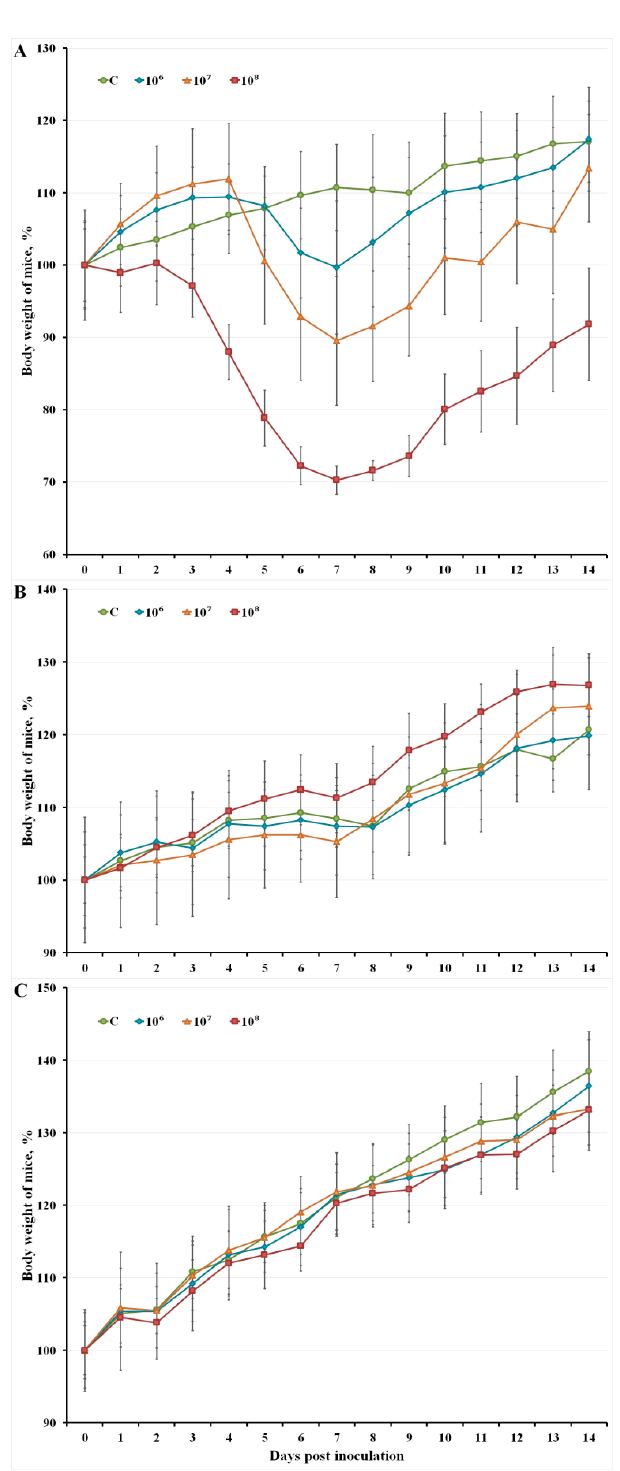
Figure 1. Changes in mouse body weight after intranasal ( A ), intradermal ( B ), and subcutaneous ( C ) inoculation with VACV LIVP-14 (doses of 10 6 , 10 7 , and 10 8 pfu) or saline solution (C, control). The error bars indicate the standard deviation of the mean of mouse body weight in each group consisting of six animals.